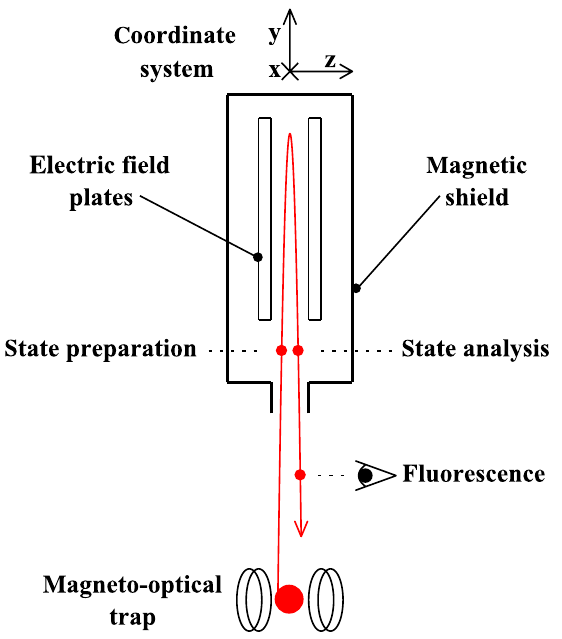
FIG. 1. Schematic diagram of an experiment to measure an electron EDM using an atomic fountain. In the diagram, the width of the parabolic trajectory has been greatly exaggerated. In first approximation, we assume that atoms rise and fall strictly along the y axis, and that the applied electric field is strictly parallel to the z axis. Atoms are exposed to lasers at the points on the trajectory marked by solid